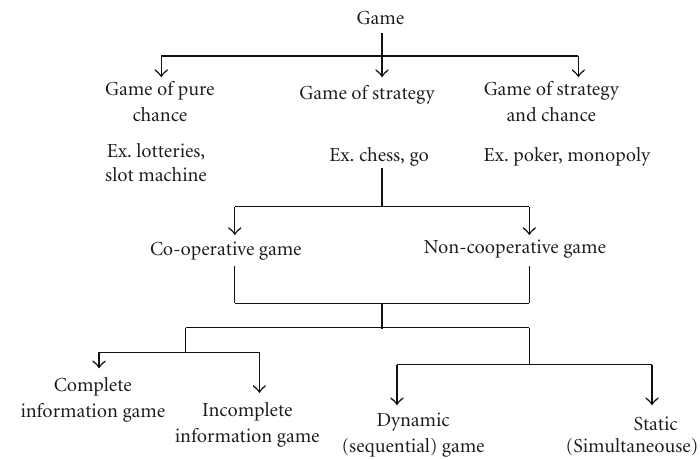
Figure 1: Classification of games.